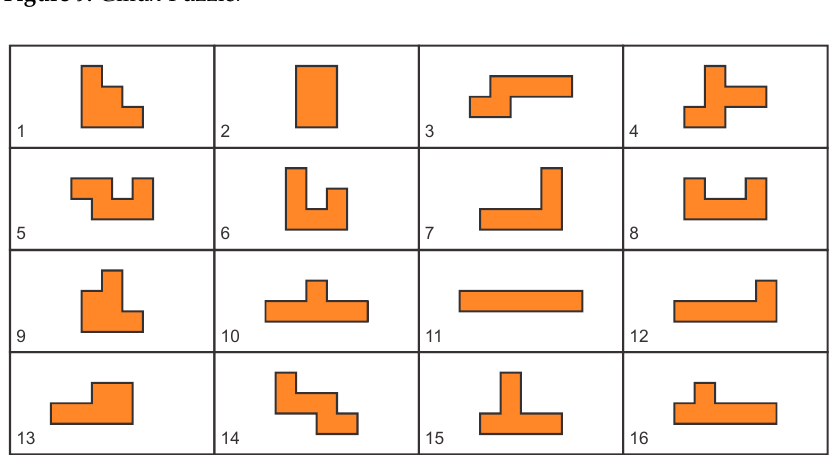
Figure 9. Gillux-Puzzle.